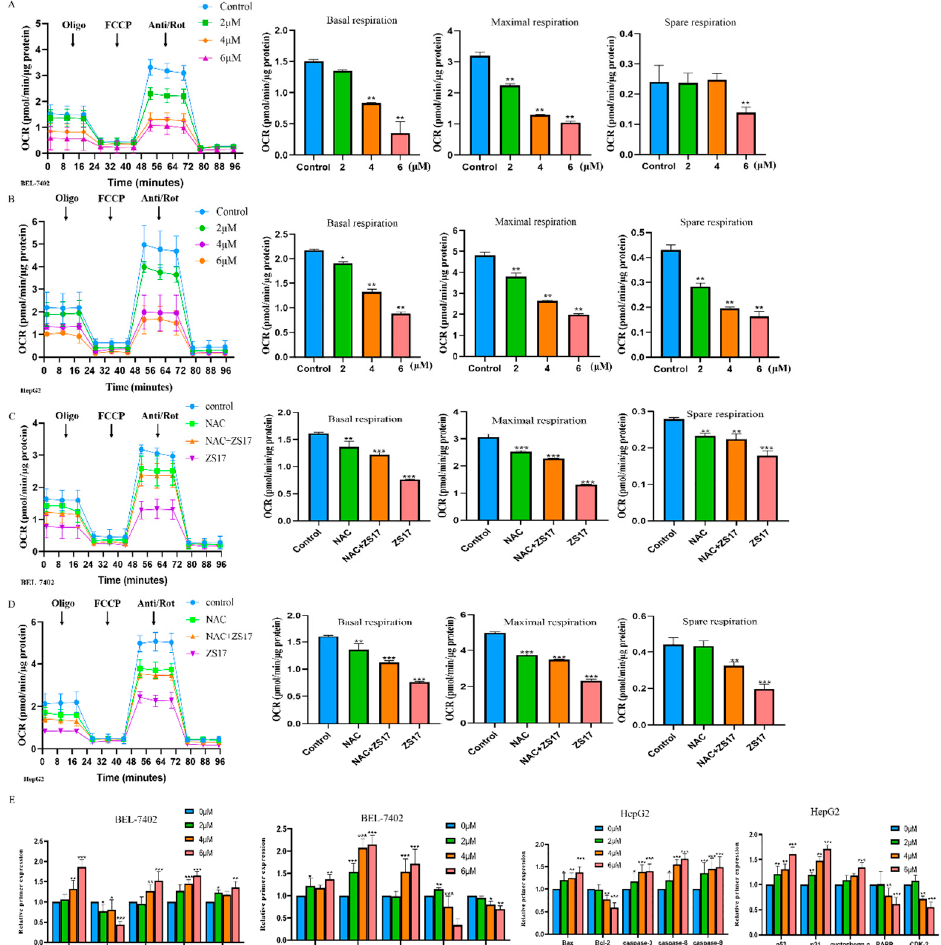
Figure 7. ( A – D ) Cellular oxygen consumption rate (OCR) was measured in real-time using the Seahorse XF96 Extracellular Flux Analyzer ( C , D ) ZS17 and co-treated with NAC in BEL-7402 and HepG2 cells. ( E ) The expression of relevant proteins at the mRNA level was detected by q-PCR. Data are expressed as mean ± SD. Compared with model group: * p < 0.5, ** p < 0.01, *** p < 0.001. n = 3 per group.